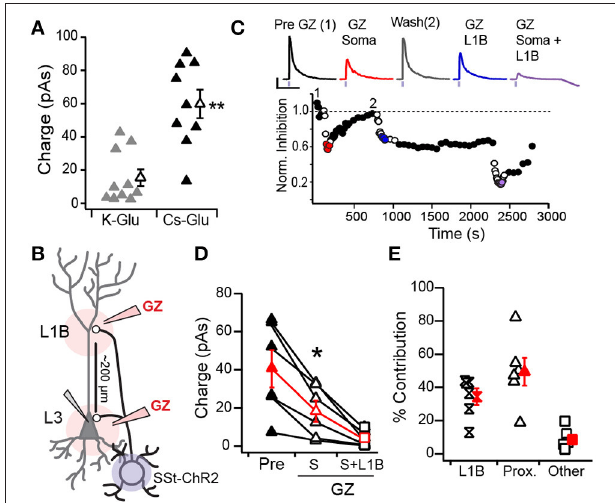
FIGURE 7 | Inhibition of L3 pyramidal cells by SST-interneurons. (A) Mean IPSC strength significantly differed recorded in pyramidal cells with K-Gluconate (gray) vs. Cs-Gluconate (black) internal solutions (** p < 0.01, unpaired t -test). (B) Schematic of locations for distal (L1B) vs. proximal (L3, soma) gabazine (GZ) application. (C) Time course of IPSCs recorded in response to somatic and distal application of GZ in an example cell. IPSC strength was normalized to the average pre-GZ strength (black circles, 1). Open circles indicate GZ applications. IPSC responses to GZ application (top) correspond to average of colored circles (Red, GZ soma; Blue, GZ L1B; Purple, GZ L1B + Soma). IPSC amplitudes recovered between somatic and L1B applications (Wash, 2) but not following L1B application. (D) IPSC strength in response to somatic GZ application (open triangles) significantly differs from pre-GZ baseline (filled triangles) and somatic + L1B application (squares, * p < 0.05, WSR-test). (E) The percent contribution of distal (L1B) and proximal (somatic) inhibition to the total inhibition recorded at baseline. “Other” corresponds to the percent of inhibition that remained during GZ application at both the soma and